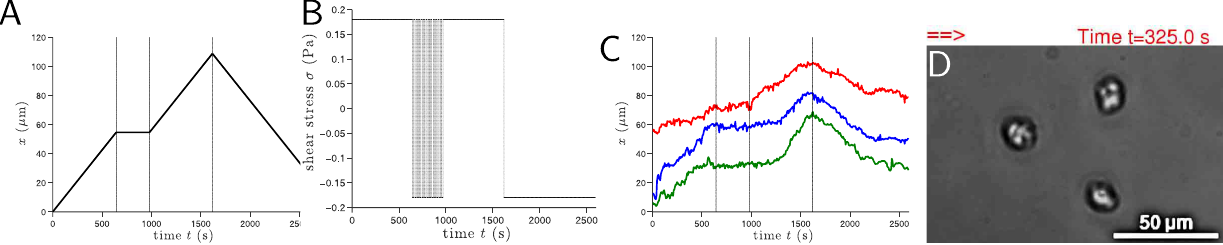
Figure 1. Prescripted cellular course. (A) Desired cellular output; (B) Imposed externally controlled mechanotactic signal; (C) Measured cellular displacement in the x direction for 3 distinct cells with a different color for each cell. The observed small differences in cellular response between the three cells are rooted in the biological variability of this sample. The initial x positions of the 3 cells have been arbitrarily shifted to circumvent the overlapping of the plots; (D) Instantaneous snapshot of the 3 cells in the observation area at instant t ~ 325 s. The double red arrow indicates the mechanostimulus direction. See SI Movie S1 for the complete migration of these 3 cells. The calcium concentration is 3 mM and the complete duration of the cellular course is 2600 seconds or 43 minutes. Cells are crawling over a plastic hydrophobic surface.